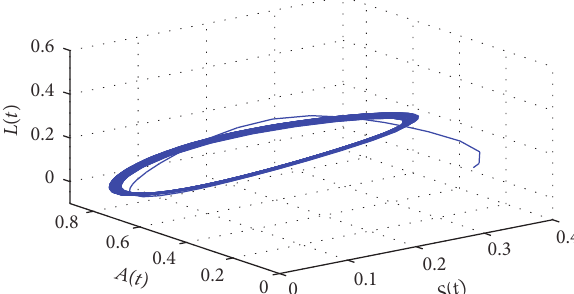
Figure 8: The phase plot of states 𝑆 ∗ , 𝐿 ∗ , and 𝐴 ∗ with 𝜏 2 = 110.96 > 95.9606 = 𝜏 20 .